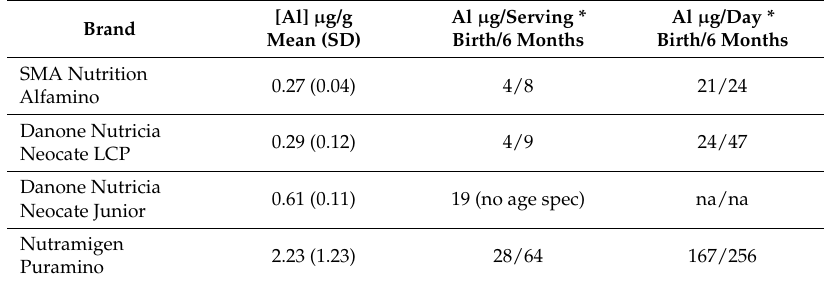
Al µ g/Day * Birth/6 Months